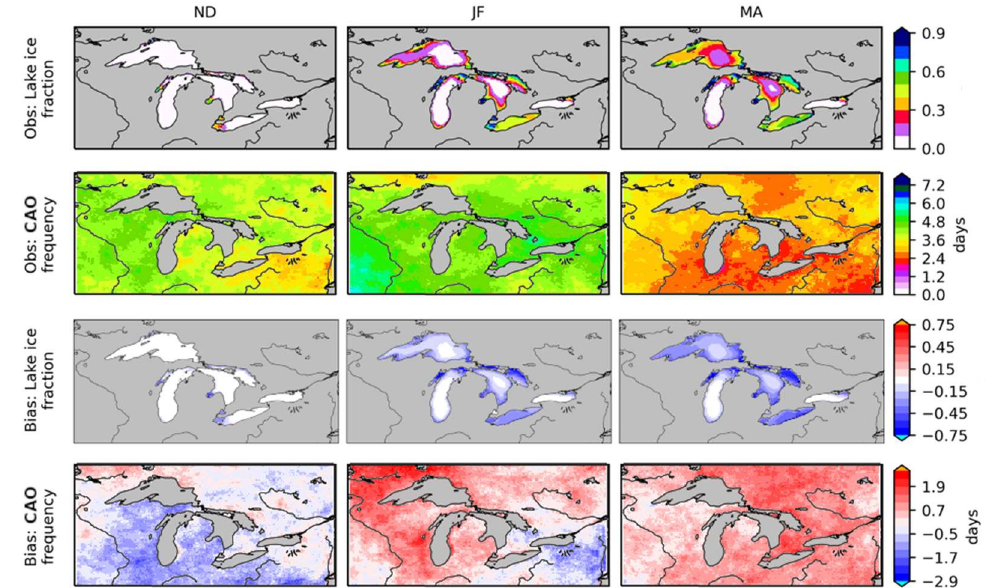
Figure 2. Observed fields (upper rows) and corresponding biases (lower rows) in the GEM_NEMOc simulated mean climatologic lake ice fraction and CAO frequency for the November–December (ND), January–February (JF), March–April (MA) periods of the 1989–2010 period. CAO frequency is not shown over the Great Lakes due to lack of reliable observation